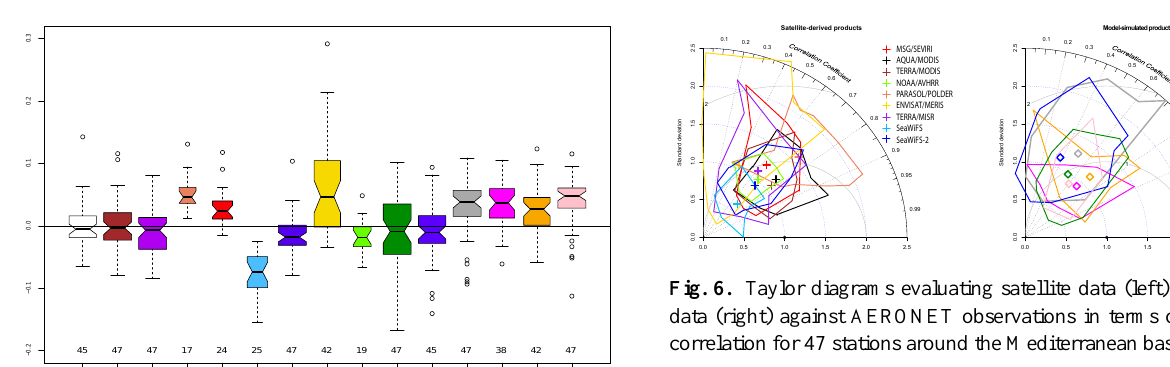
45 47 47 17 24 25 47 42 19 47 45 47 38 42 47